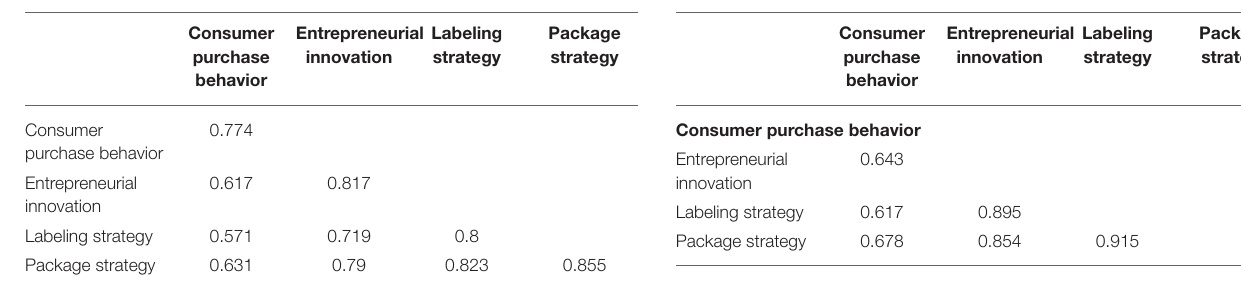
TABLE 2 | Fornell & Larcker. TABLE 3 | HTMT